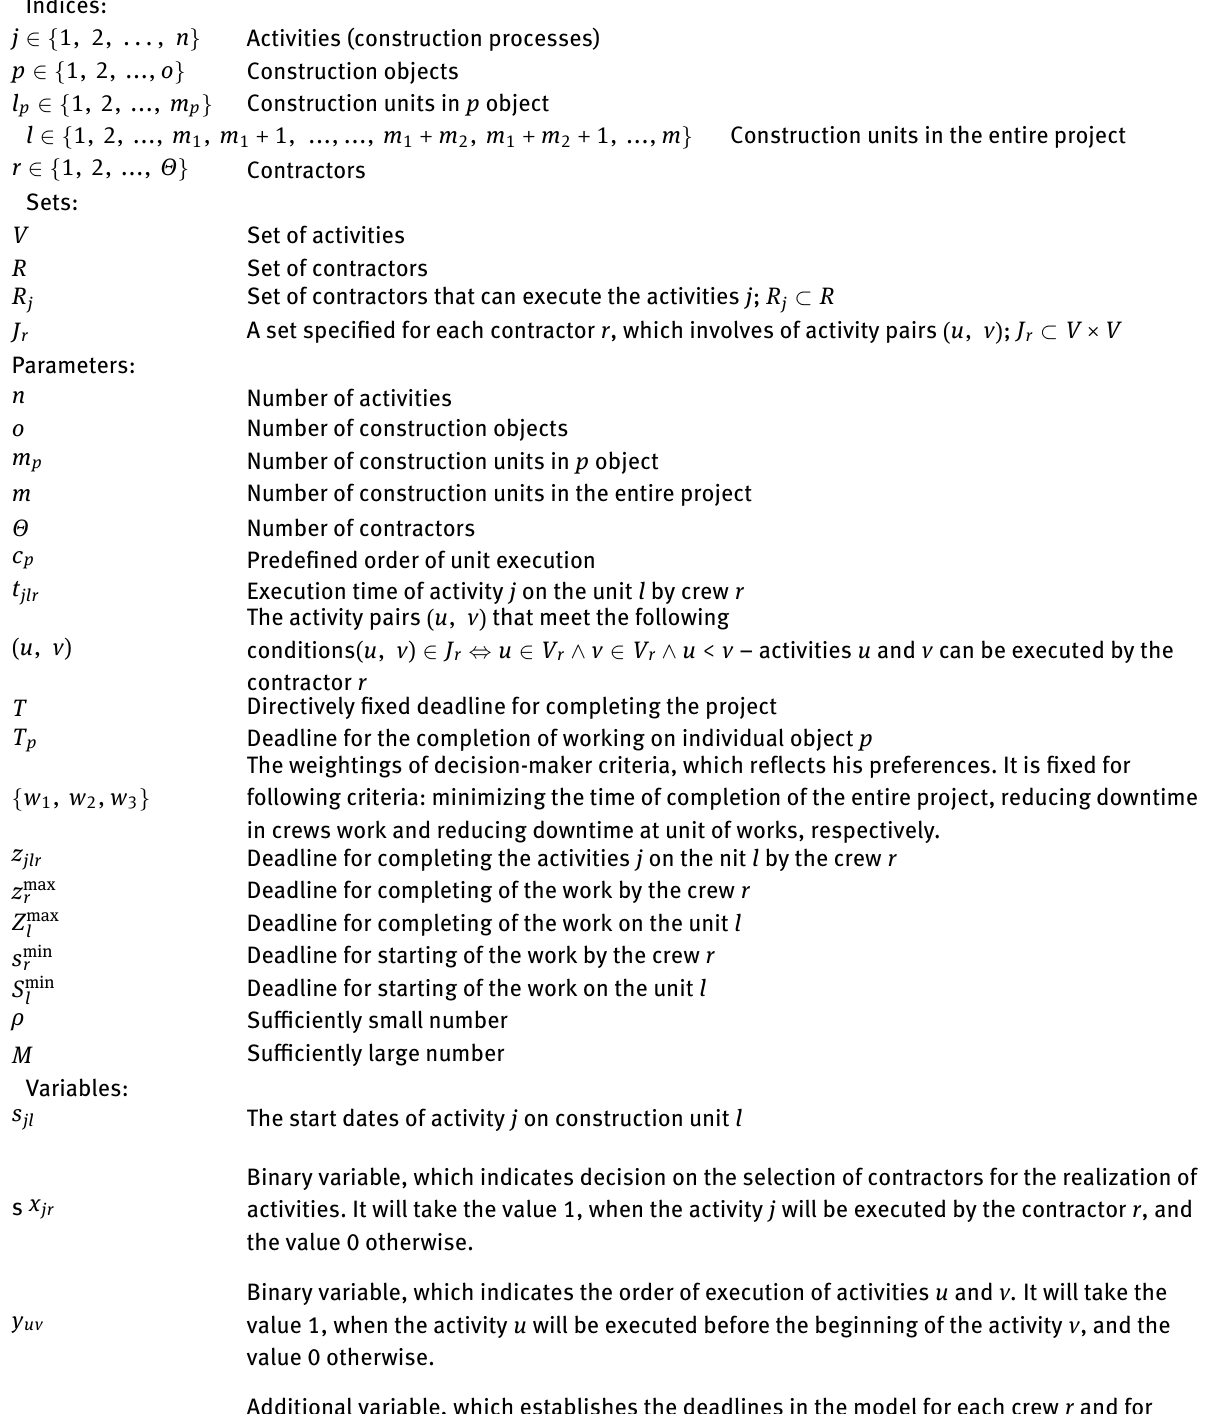
Table 1: Model indices, sets, parameters and